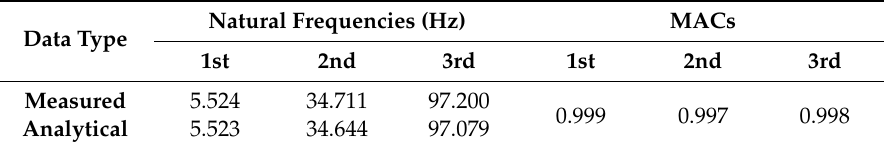
Table 5. Measured and analytical natural frequencies and MACs of the undamaged